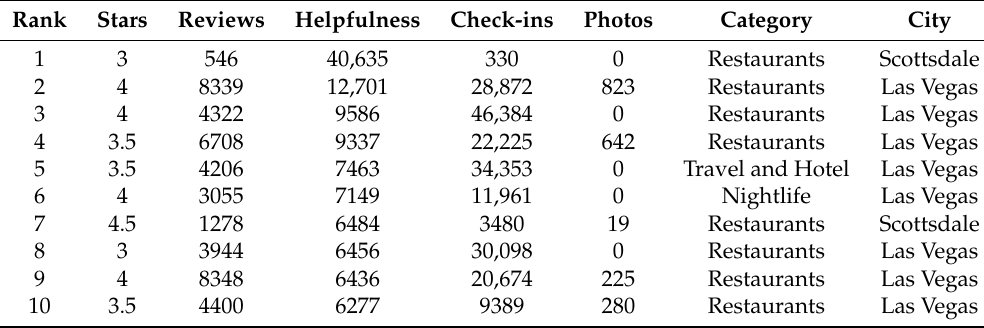
Table 4. Top 10 businesses by cumulative